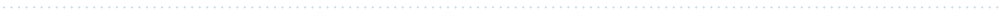
in vitro CD8 + T cell migration assay using the culture supernatant of HCC827 cells ( EGFR- mt) with or without